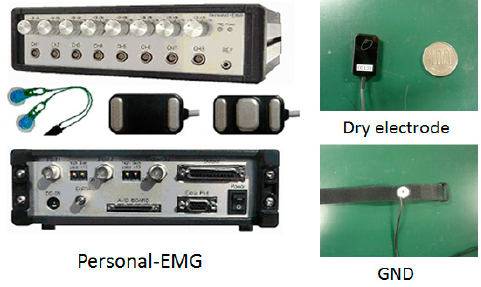
Figure 2. Experimental setup of surface electromyography (sEMG) acquisition.